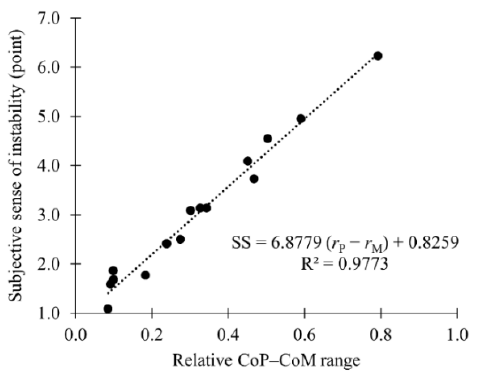
Figure 10. Relationship between the subjective sense of instability (SS) and the relative range of the center of mass (CoM) to the center of pressure (CoP) distance ( r P − r M ).